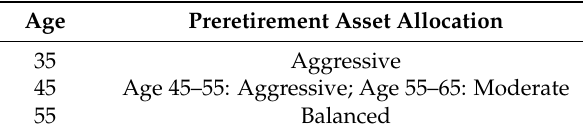
Table 1. Preretirement asset allocation.